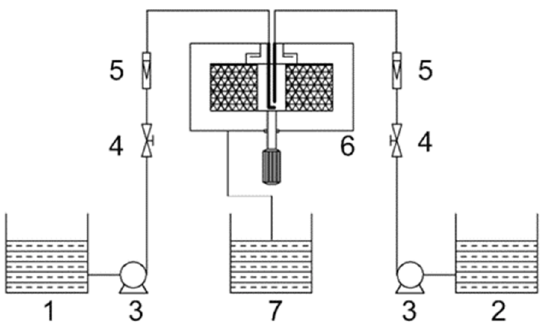
Figure 1. Experimental setup: 1, 2: liquid storage tank; 3: pump; 4: valve; 5: rotormeter; 6: impinging steam-rotating packed bed (IS-RPB); 7: collection tank.